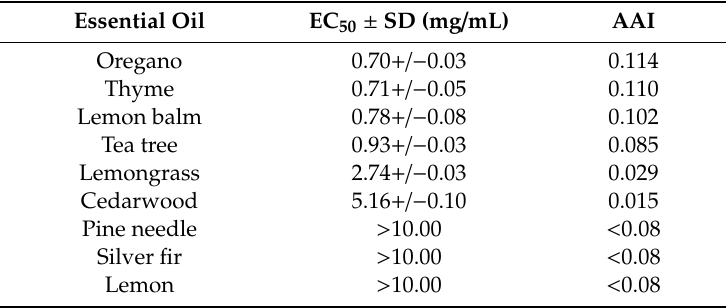
Table 3. Antioxidative activity of selected essential oils.